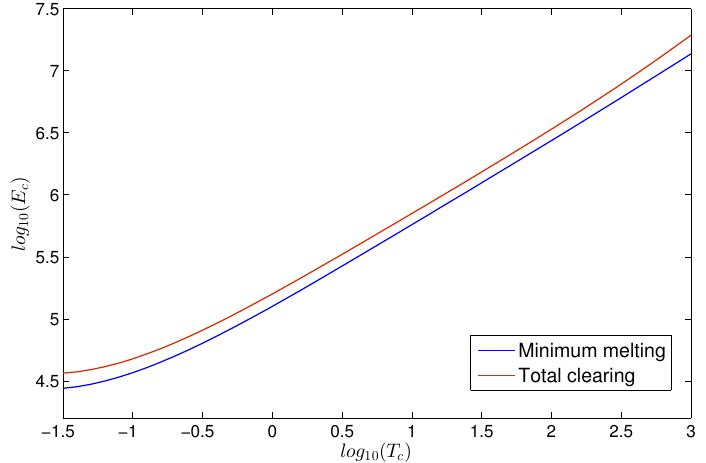
Figure 6. Catalog energy/time curves of obtained from manufacturer data.